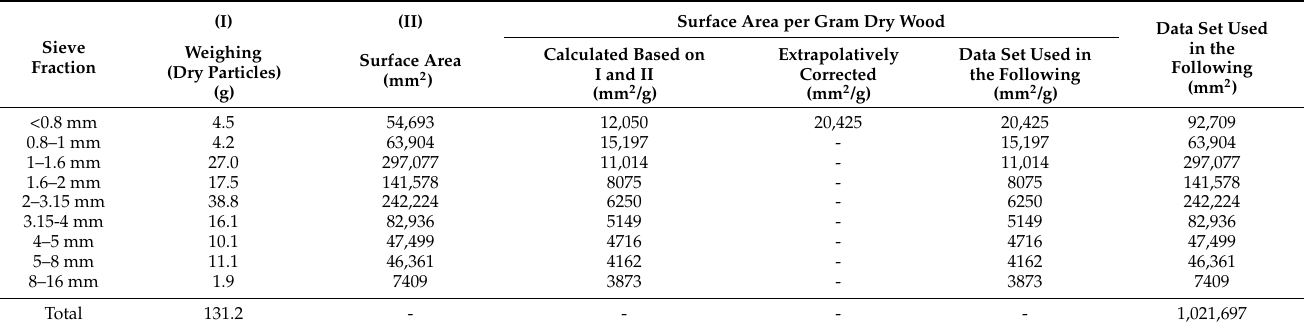
Table 3. Total dry particle mass and surface area of the three measurement runs as well as the calculated or extrapolatively corrected surface area per gram dry particles for each sieve